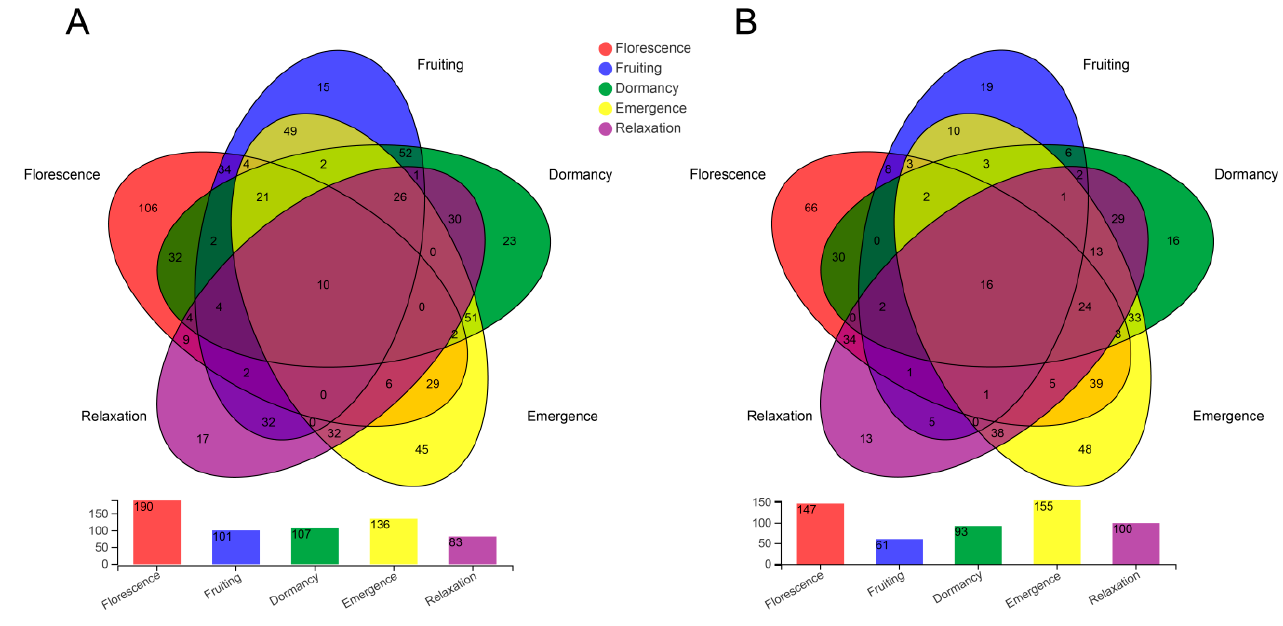
Figure 3. The operational taxonomic unit (OTU) level of species composition during different phenological stages for Bletilla striata ( A ) and B. ochracea ( B ).